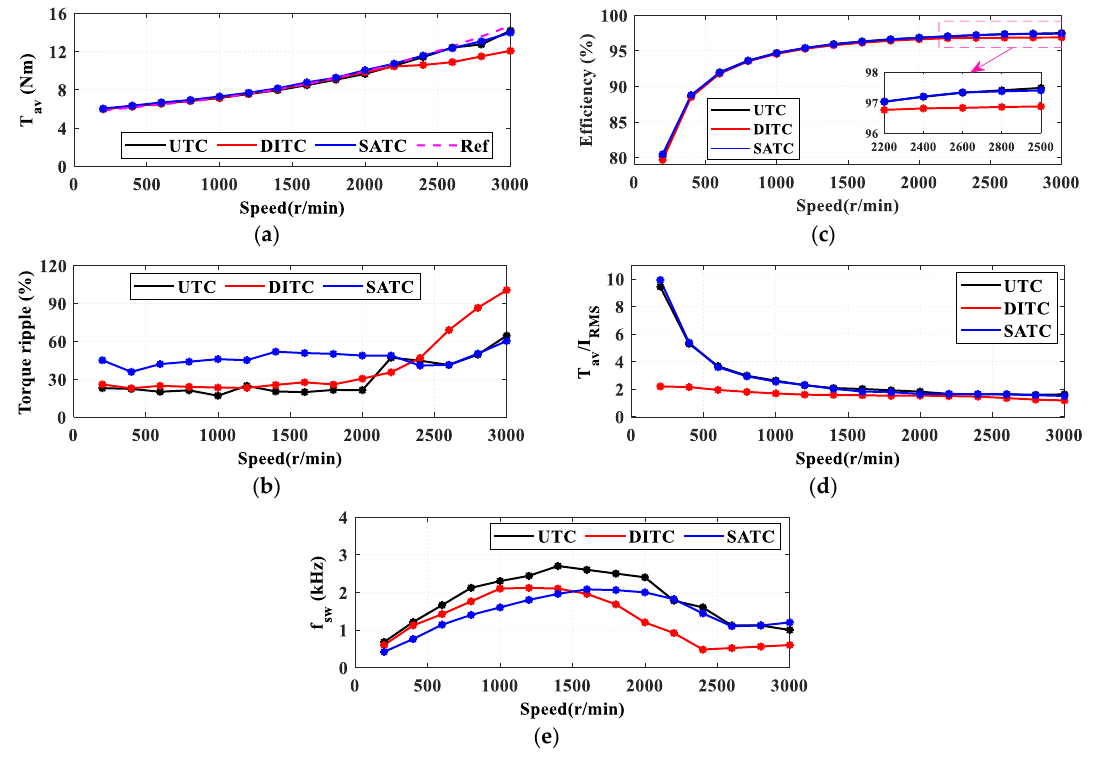
Figure 18. The steady state characteristics under EV loading profile. ( a ) Average torque; ( b ) torque ripple; ( c ) efficiency; ( d ) torque/current ratio; ( e ) switching frequency.